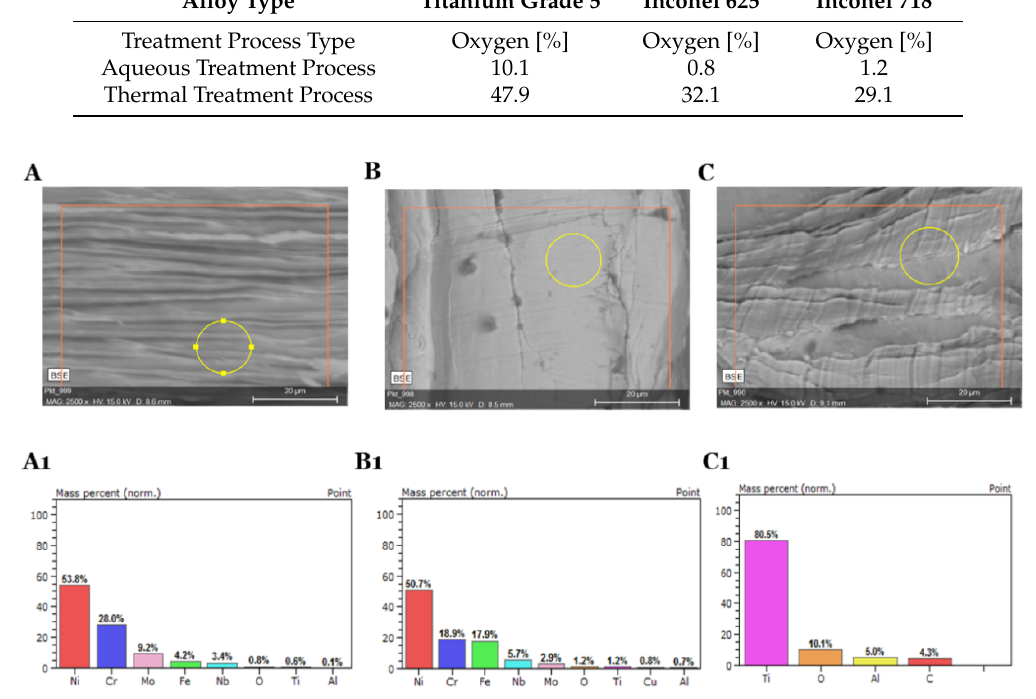
Figure 5. SEM-EDS photos after oil removal from Inconel 625 ( A , A1 ), Inconel 718 ( B , B1 ), Titanium Grade 5 ( C , C1 ) swarfs in aqueous treatment process (Spirdane D40 after 60 min) with the elemental composition of the surfaces.